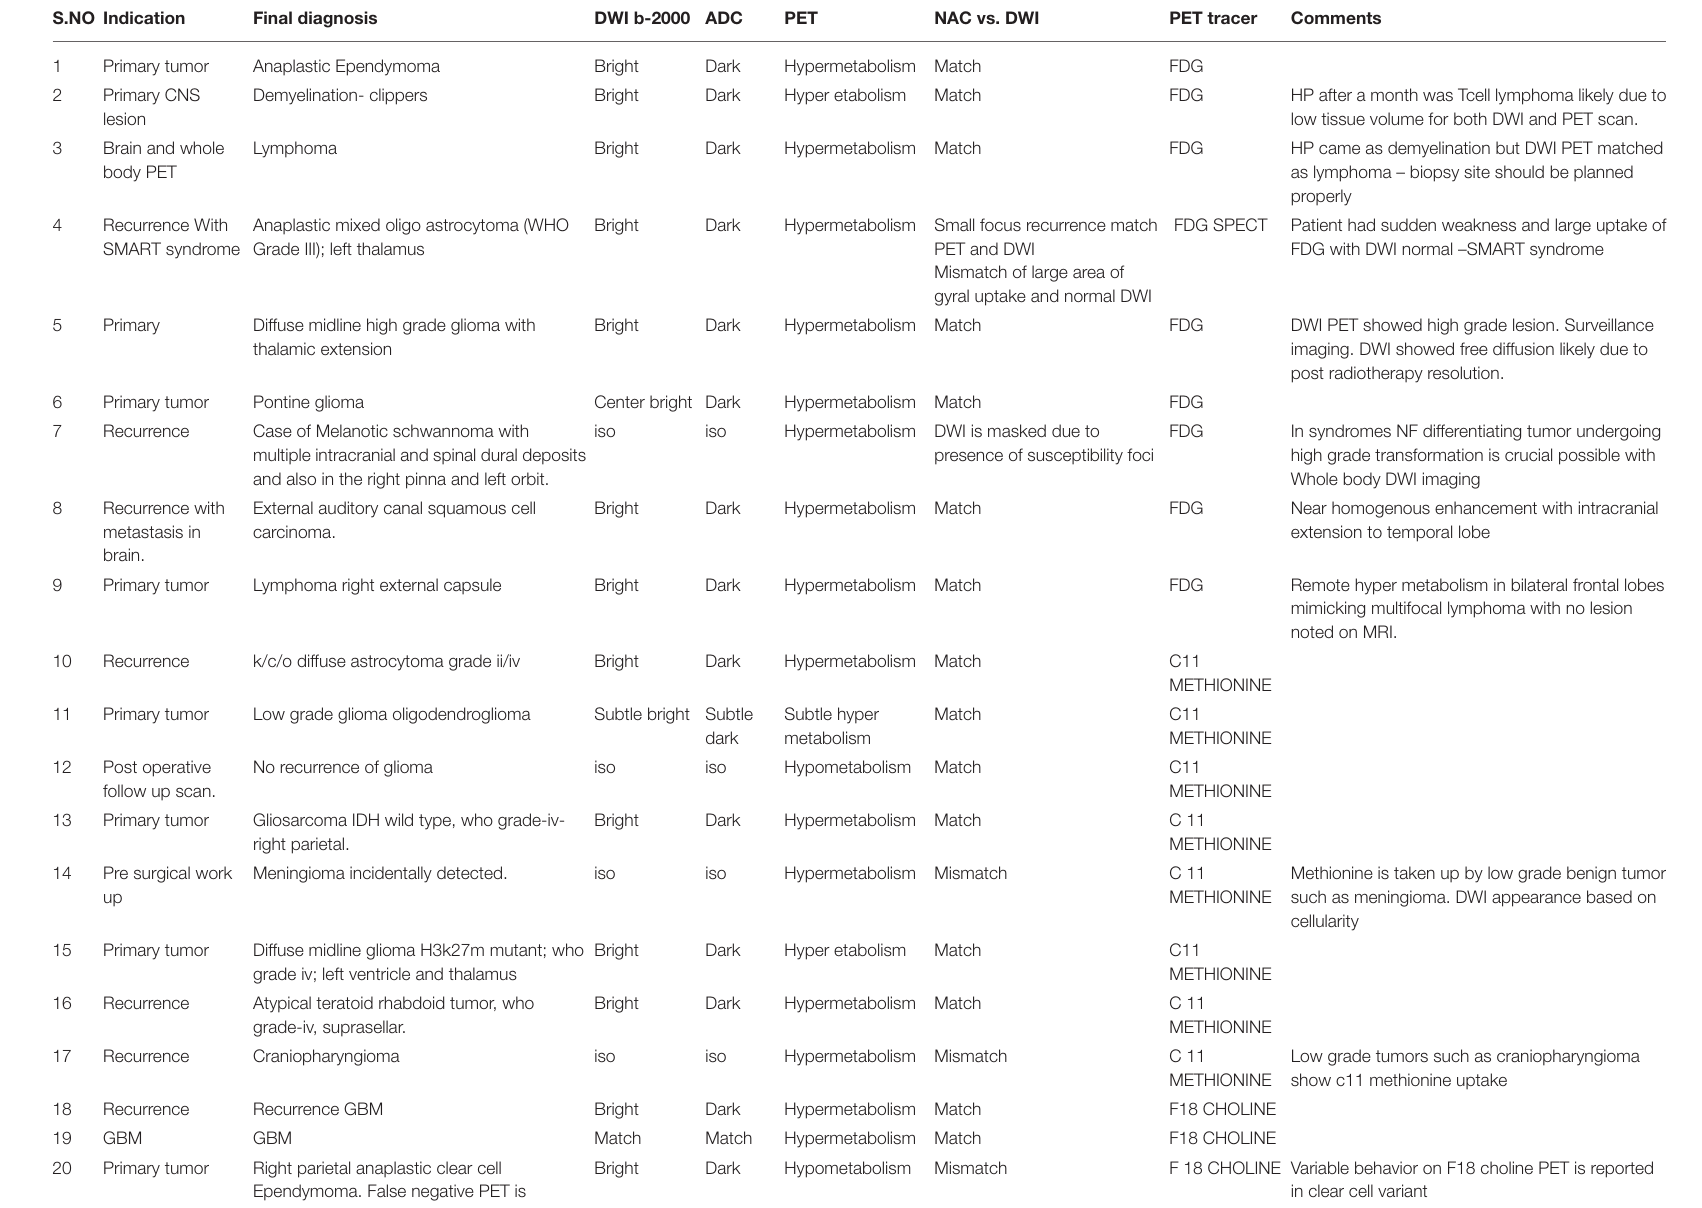
TABLE 2 | Brief summary of other CNS histotypes cases evaluated with MRI FDG-PET and other PET tracers. S.NO